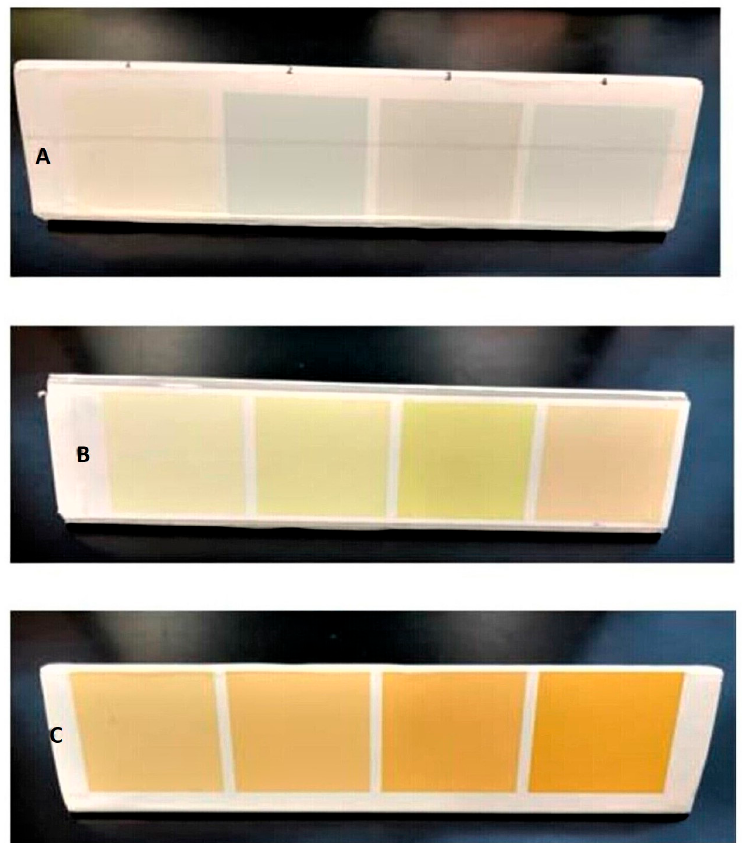
Figure 1. Preliminary HMCG tool comprising 12 shades (December 2018 version). The lighter ‘watery’ shades are grouped in the first row (row A ), the ‘regular white’ appearing shades in the second row (row B ), and the ‘creamy yellow’ appearing shades are in the third row (row C ). Based on preliminary analysis (104 milk samples), certain shades that did not match with su ffi cient milk samples were eliminated; similarly, shades with poor inter-observer correlation were excluded. Some new shades were added based on direct observations, and a simpli fi ed color tool with 9 color shades (3 colors in each row) was created. The fi nal HMCG tool (October 2019 version) is shown in Figure 2. Figure 2. HCMG tool with 9 color shades (October 2019 version) . Note: colors from www.Behr.com [35]. A1—Cauli fl ower M340-1 White, A2—Silent White PPU26-13, A3—Wind Chill BL-W07; B1— Glass of Milk P260-1, B2—E ff ervescent P310-1, B3—Natural Light P310-2; C1—Yogurt P260-2, C2— Vanilla Ice Cream P260-3, C3—Hummus PPU6-11.